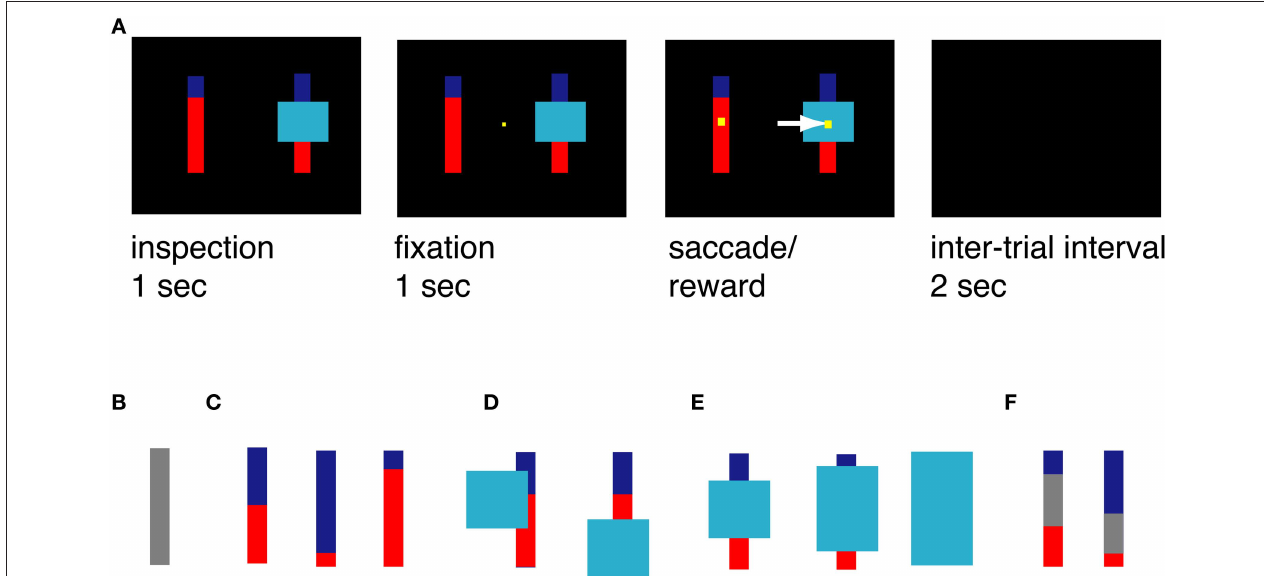
options. Blue/red bars yield either 333 or 67 μL juice; probability can vary from 0 to 100%. In this example, probabilities of large reward are 50, 88, and 17%, corresponding to the size of the blue portion of the bar. (D) Example of risky option with partially covering occluder that did not render probabilities ambiguous. (e) Ambiguous options. The size of the occluder rendered the bar either low, medium, or high ambiguity (left to right). (F) Examples of stimuli used in triple bar control